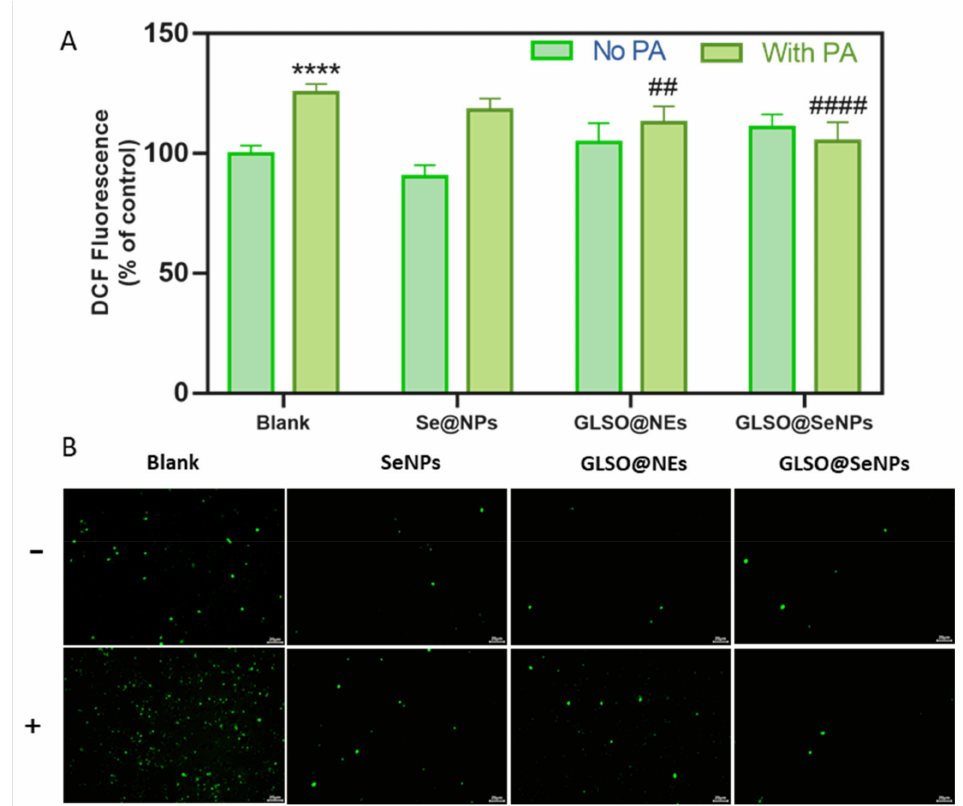
Figure 5. GLSO@SeNPs prevent PA-induced ROS generation in INS-1E cells. ( A ) ROS production changes in INS-1E cells after incubation with 0.04 µ L/mL GLSO@SeNPs, 0.04 µ L/mL GLSO@NEs, and 0.4 mM SeNPs for 6 h followed by PA stimulation for 12 h (cells were stained with DCFH-DA for 20–30 min; n = 6). (## p < 0.01 means moderate significance, **** (####) p < 0.0001 means the